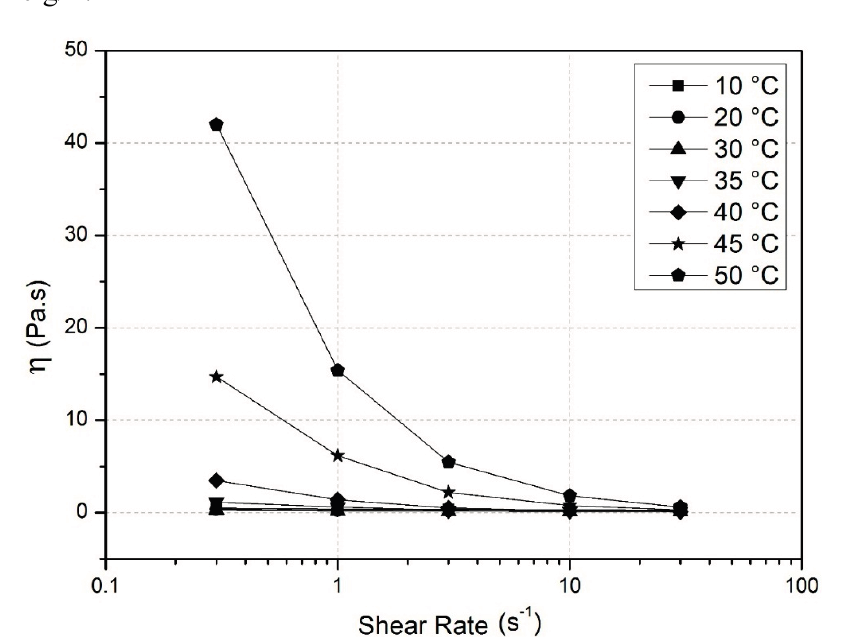
Figure 1. Influence of viscosity obtained from dynamic measurements using Cox–Merz transformation as a function of shear rate at different temperatures of methylcellulose A4M solution at 10 g/L.